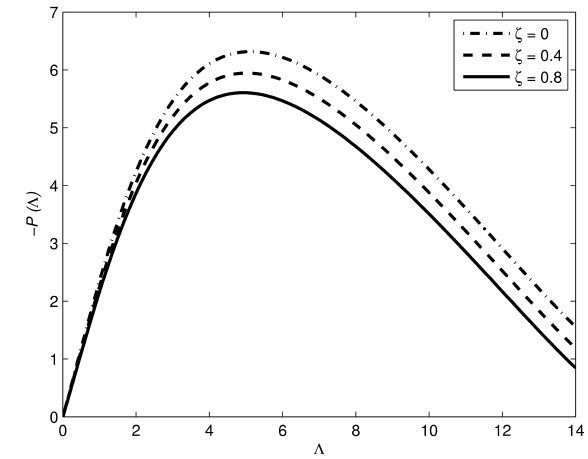
Figure 14: Effect of Re on F ( Λ ) keeping ζ = 0.5 , η = 0.2 , C 1 = C 2 = C 3 = 50 , Pr = 6.8 , and Br = 5